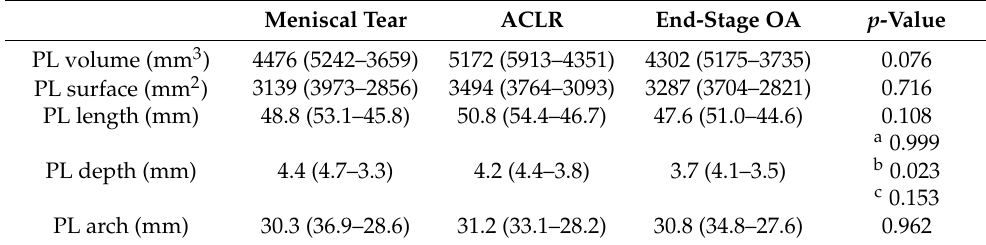
Table 4. PL characteristics in patients with meniscal tear, ACLR, and end-stage OA.